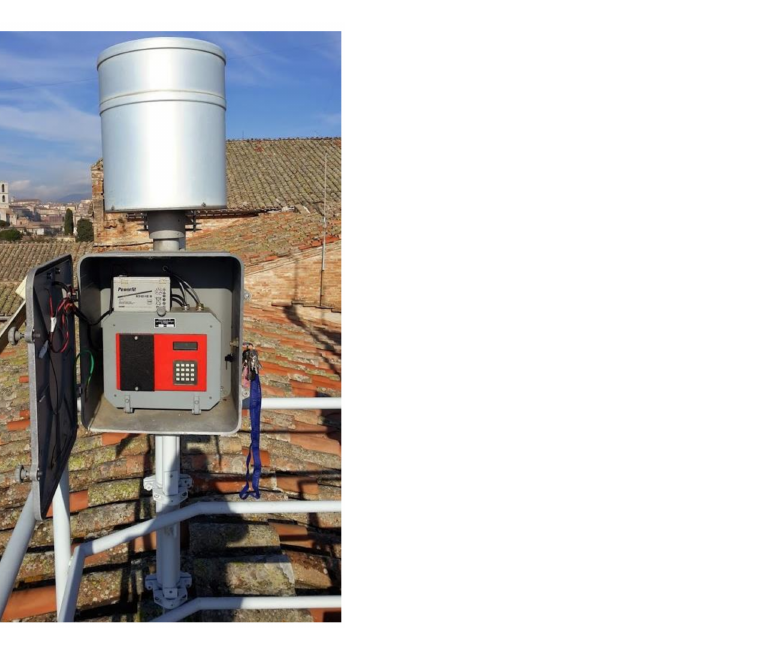
Figure 1. Rain gauge with digital data logger correctly working at Perugia (central Italy).